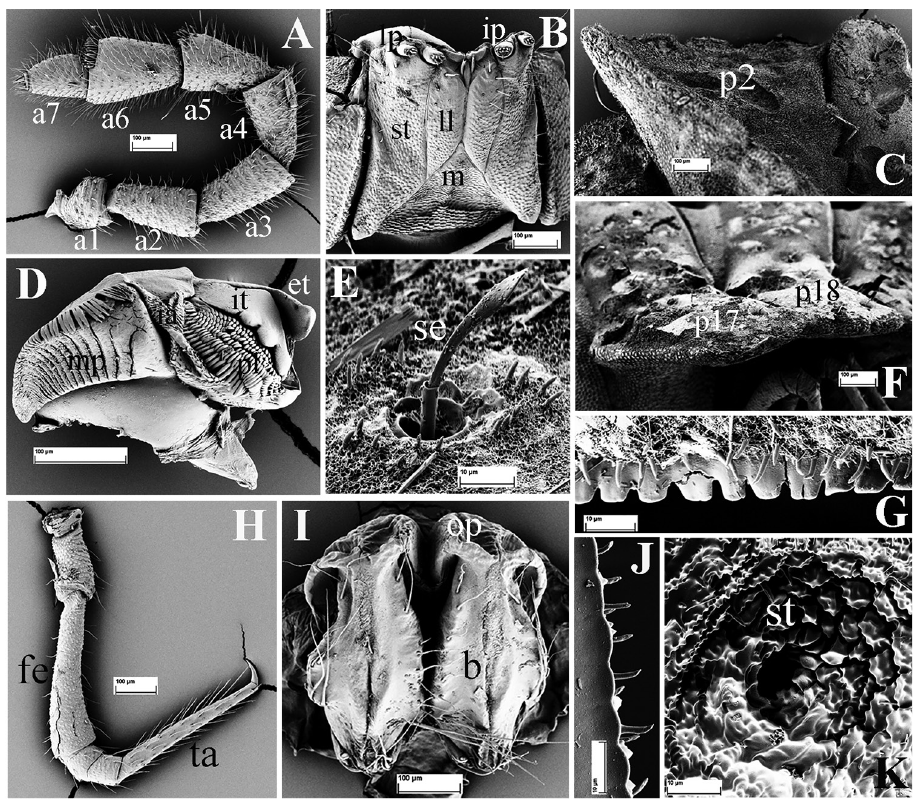
Figure 9. E. paraster sp. n., SEM, male holotype from Cave Tham Long Puang. A right antenna, lateral view (a1–a7 = antennomeres 2–7) B gnathochilarium, ventral view (lp = lateral palpus; ip = inner palpus; st = stipites; ll = lamellae linguales; m = mentum) C paratergum 2 (p2), dorsal view D right mandible, general view (et = external tooth; it = internal tooth; pl = pectinate lamellae; ia = intermediate area; mp = molar plate) E a seta (se) on metatergum 18 F paraterga 17 (p17) and 18 (p18), lateral view G limbus of metatergum 5, dorsal view H midbody leg, frontal view (fe = femur; ta = tarsus) I female paratype, vulvae, general view (op = operculum; b = bursa) J endotergum 5 K stigmata (st), ventral